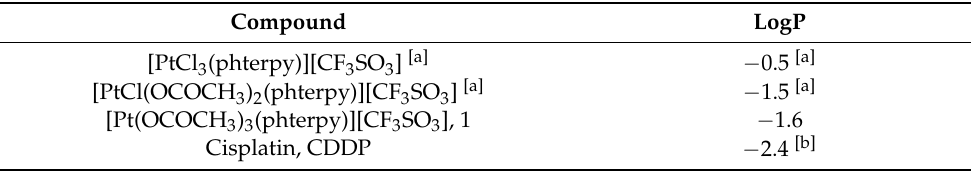
Table 2. LogP values of selected complexes.